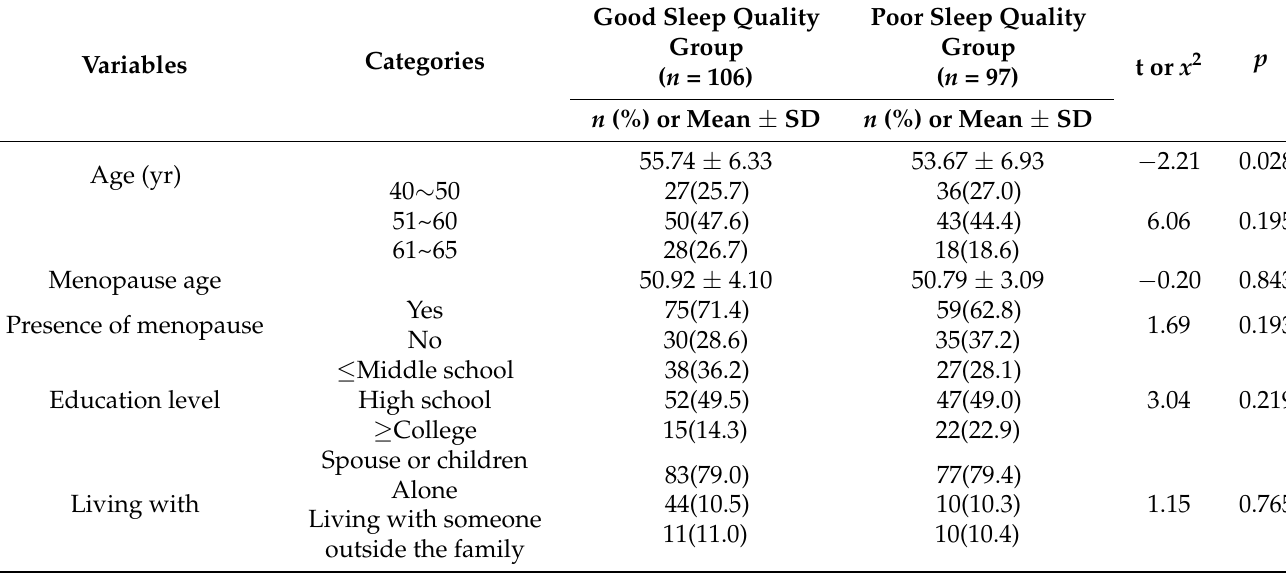
Table 1. General characteristics of the participants. ( N =